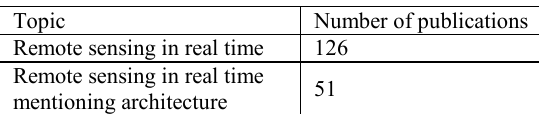
Table 6. Number of publications in real time remote